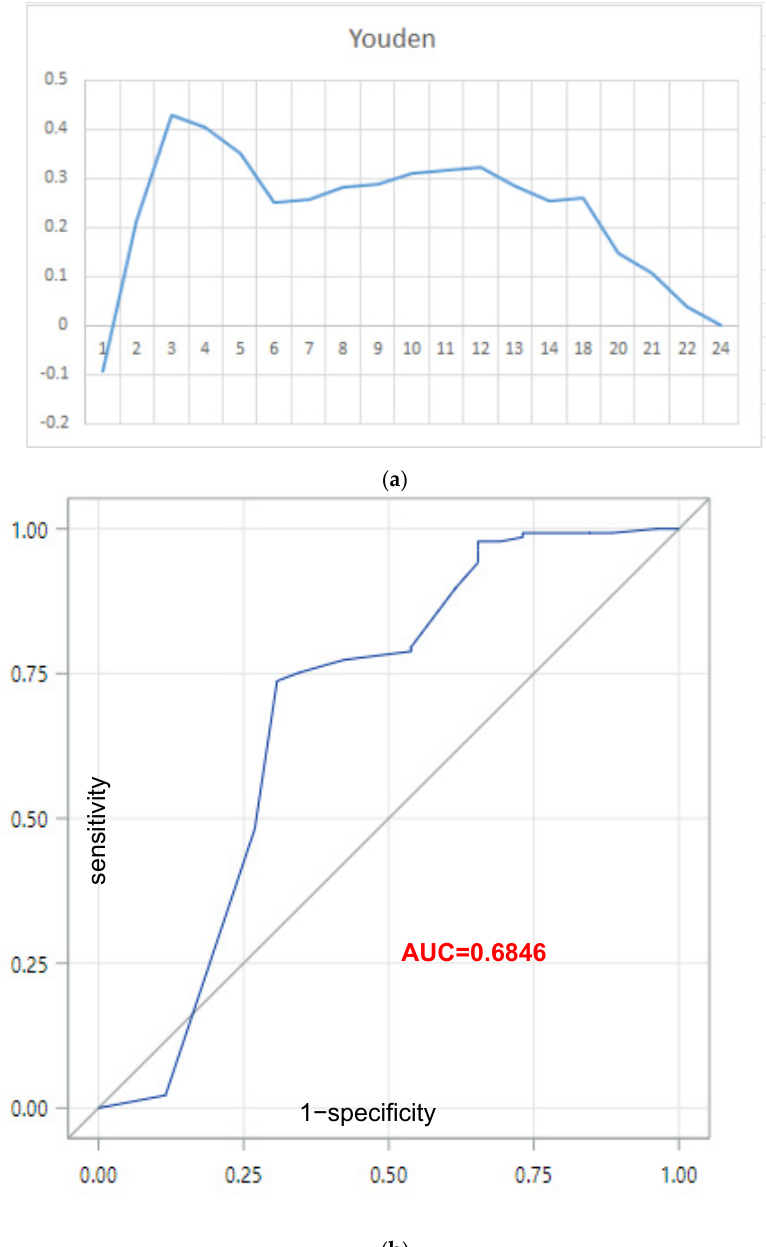
Figure 2. In ( a , b ), using receiver operating characteristic (ROC) curve analysis used to evaluate the association between initiating anti-osteoporotic medication and the interval between an outpatient visit following a new diagnosis of a vertebral fracture. The figure shows that outpatient visits within 3 months had the highest Youden index (0.43) and the highest maximum area under the curve (AUC = 0.6846). ( a ) Youden index, ( b ) When the cutoff point was 3, the maximum AUC was 0.6846.